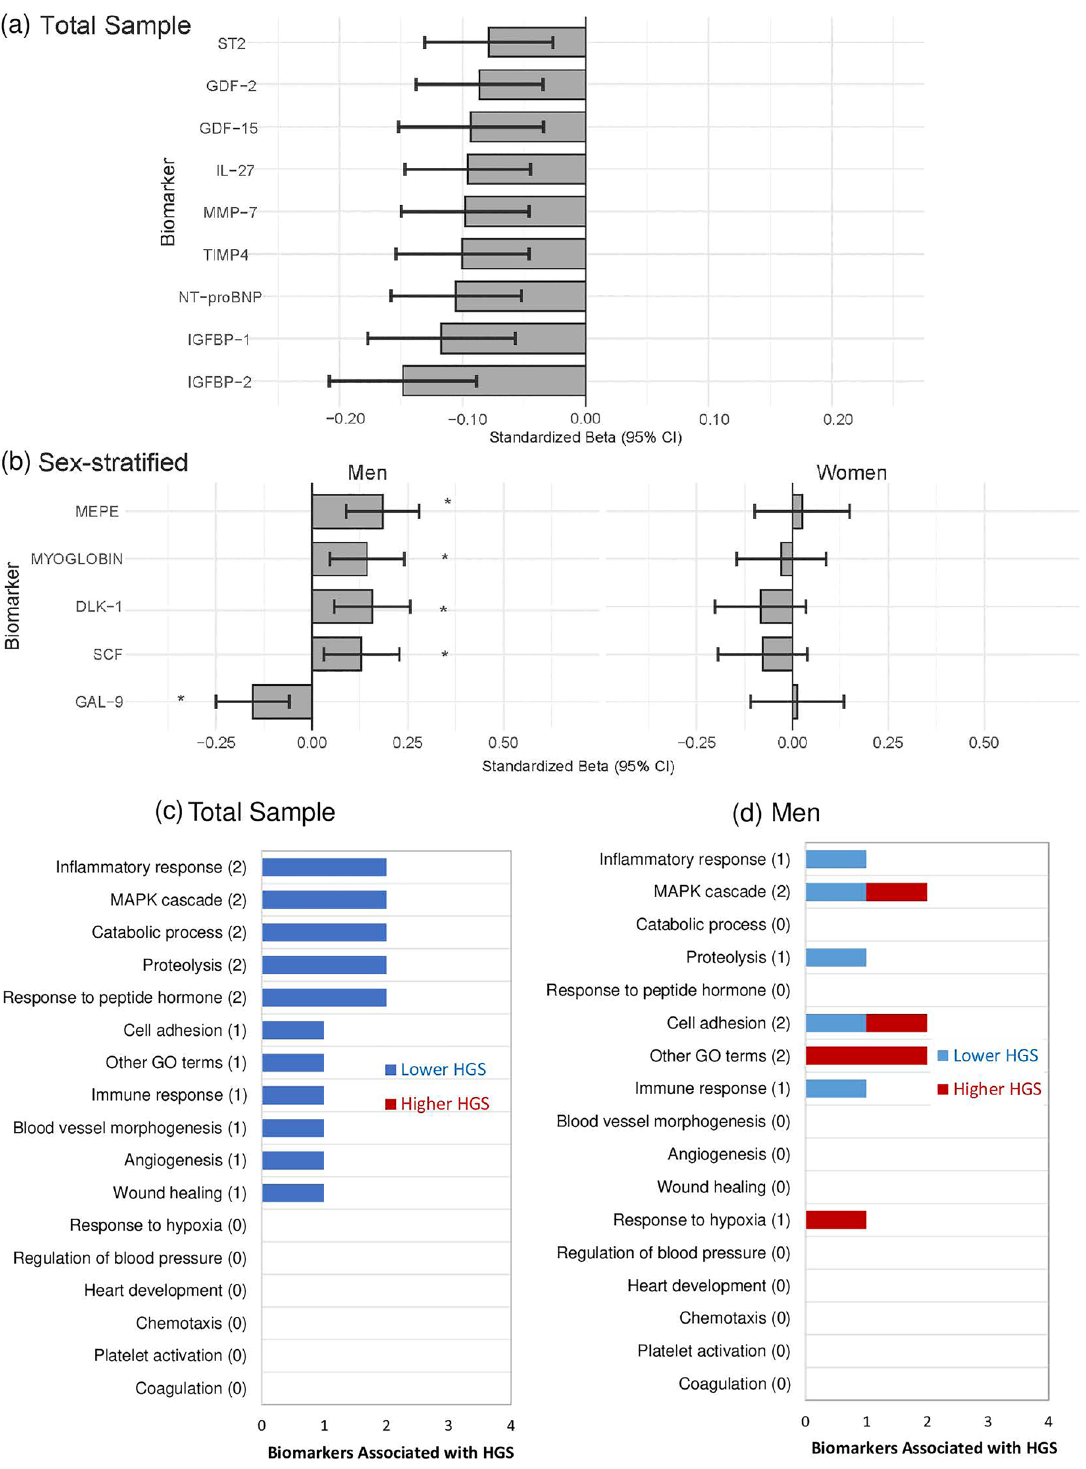
Figure 5. Associations between biomarkers and HGS. Linear regression models ( a , b ) were adjusted for age, height, sex, smoking, alcohol, HFIAS total score, total physical activity (ENMO), visceral adipose tissue, and HIV status. Menopause status was included as an additional confounder in women. The numbers in brackets represent total biomarkers associated with the outcome and related to the respective biological process. The list of biomarkers associated with the biological processes are based on the OLINK website (www. olink. com/ produ cts- servi ces/ target). *False-discovery rate adjusted P value < 0.05; Standardized Beta: Standardized Beta coefficient; 95% CI 95% Confidence Intervals; GO: Gene Ontology. Full names of all biomarkers are listed in Additional Table